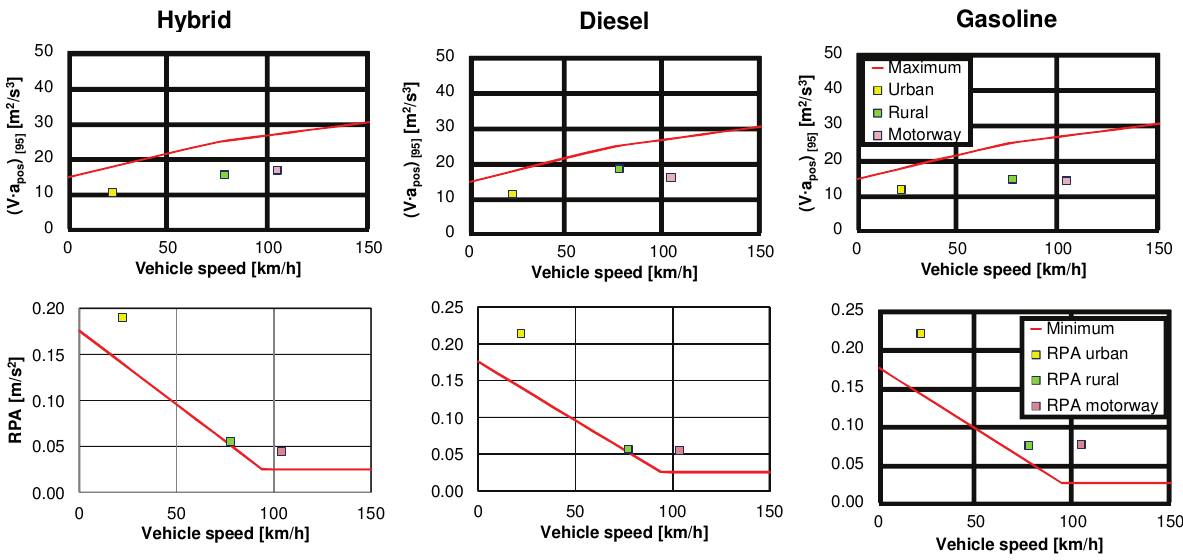
Fig. 13. Comparison of the drive dynamics conditions for each of the tested